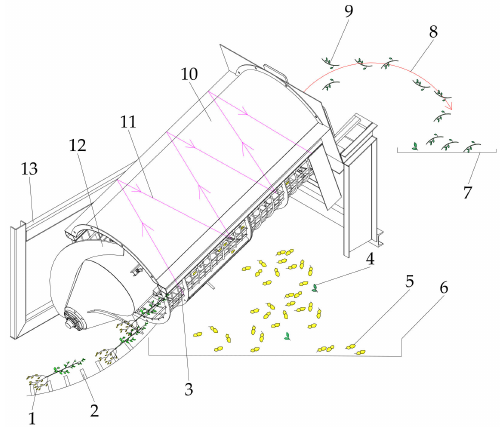
Figure 3. Working principle diagram of an axial-flow pod-pickup drum. 1. Peanut plant; 2. Con- veying mechanism; 3. Concave grate; 4. Leaves; 5. Peanut pods; 6. Pod-conveying mechanism; 7. Seedling-vine-conveying mechanism; 8. Track of broken seedling vine; 9. Broken seedling vine; 10. Cover shell; 11. Plant movement track; 12. Screw conveyor; 13.